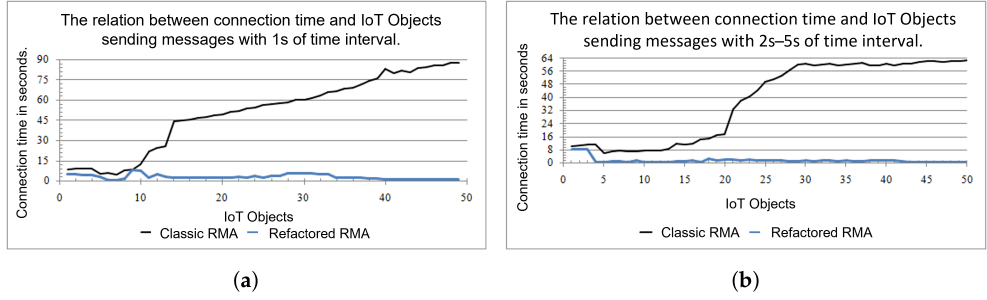
Figure 8. Connection time comparison between the RMA and the refactored RMA: ( a ) considering 1 s interval of messages; ( b ) considering considering an up to 5 s interval of messages.